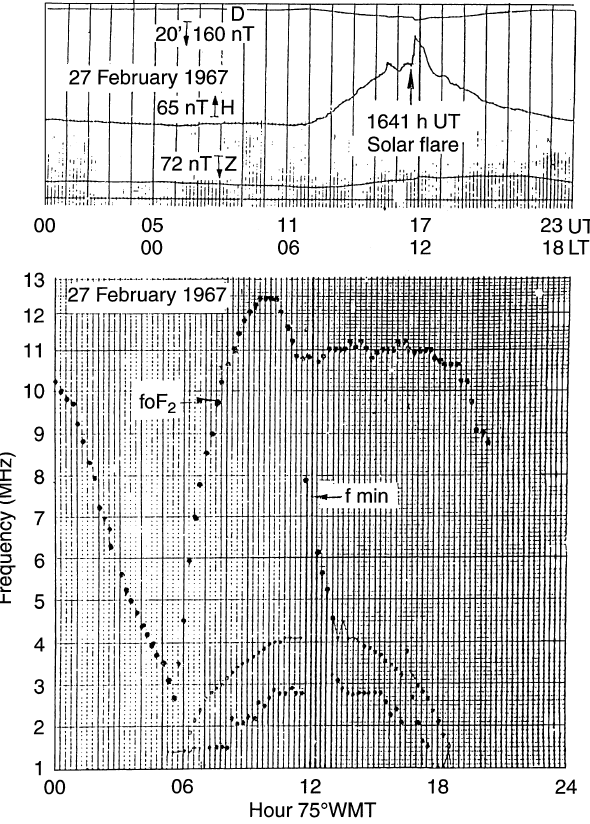
Fig. 9. Magnetograms and ionospheric f-plots at Huancayo associ- ated with solar flare on February 27, 1967